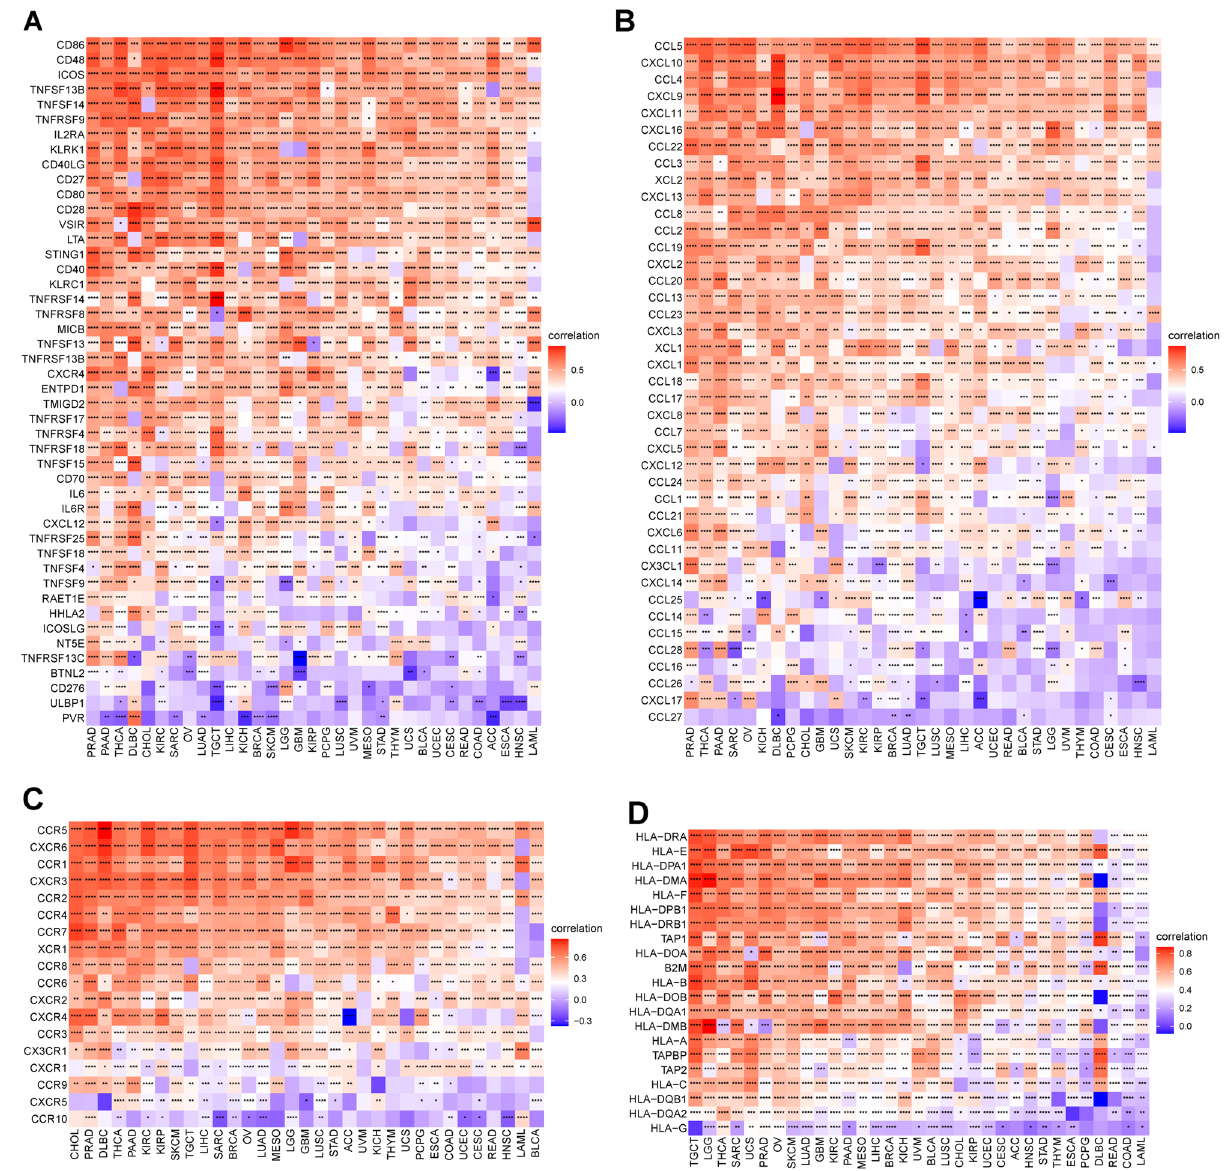
Figure 11. Correlation between PANoptosis score and immune associated genes. ( A ) immune activated genes. ( B ) Chemokines. ( C ) Chemokine receptors. ( D ) MHC genes in pan-cancer. * P < 0.05, ** P < 0.01, *** P < 0.001, **** P <